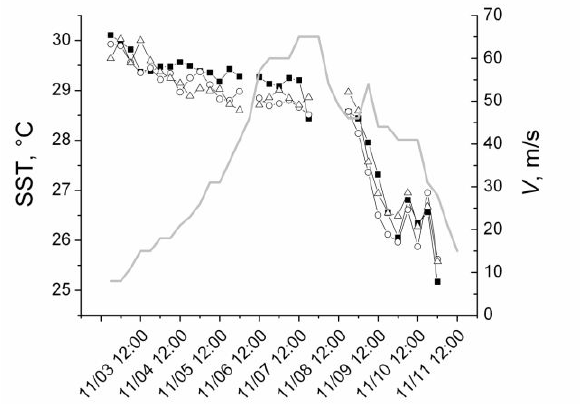
Figure 8. SST along TC Haiyan track (marked lines) and the TC intensity (thick gray line), see paragraph 6.2 for details